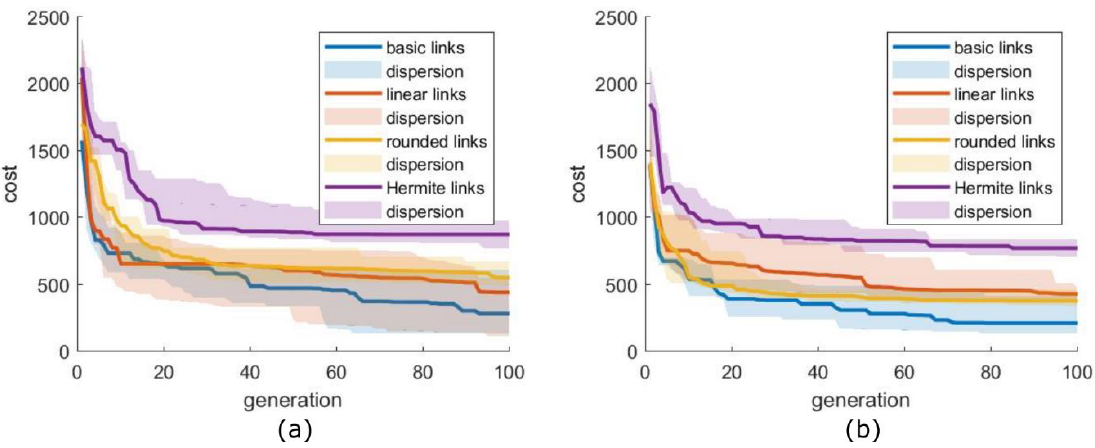
Figure 14. Results for task 3: ( a ) cost 1 ; ( b ) cost 2 .